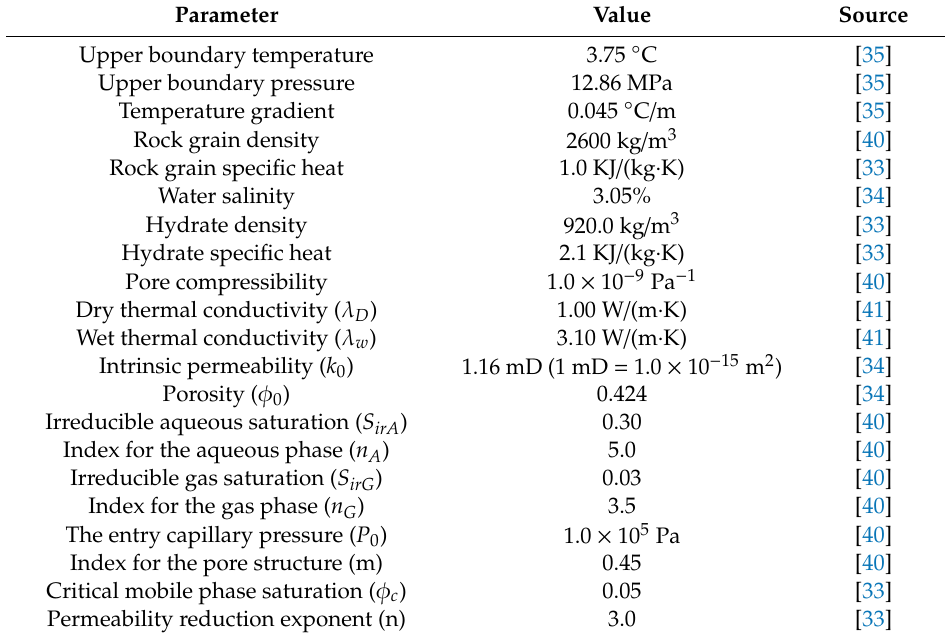
Table 1. Main model parameters of site W19 in the Shenhu area of the